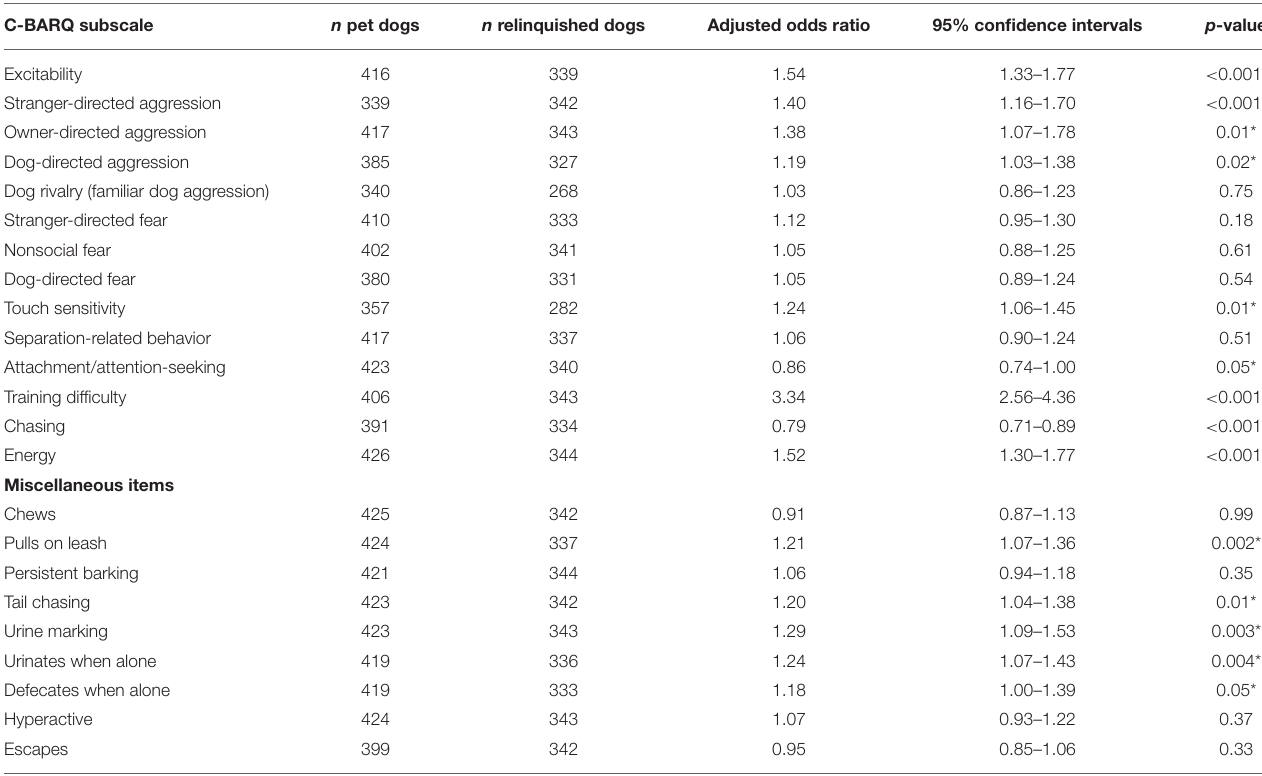
TABLE 2 | Association between relinquishment status and C-BARQ subscale or miscellaneous item scores. C-BARQ